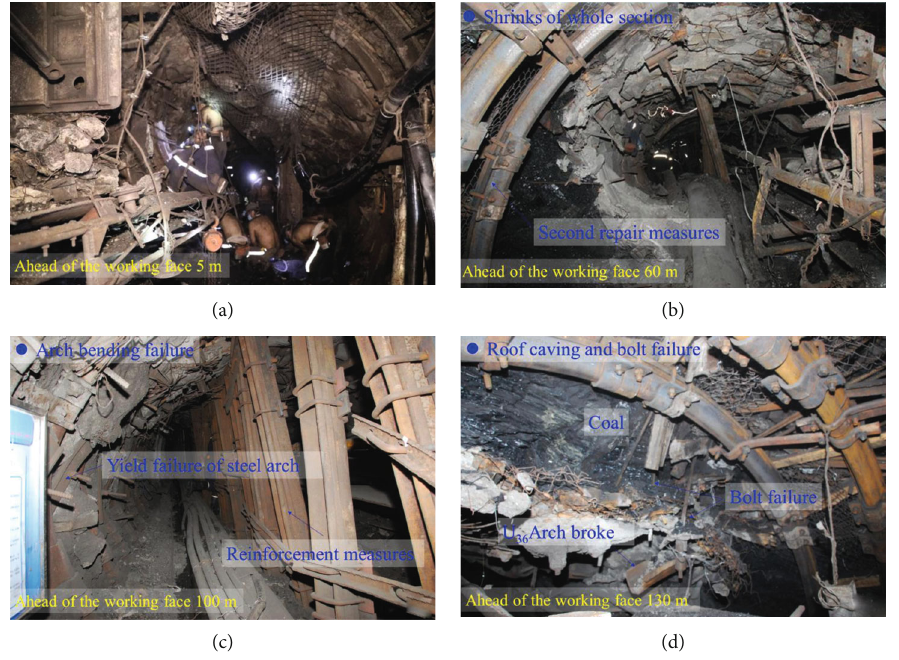
Figure 4: Failure phenomenon of the S2N5 working